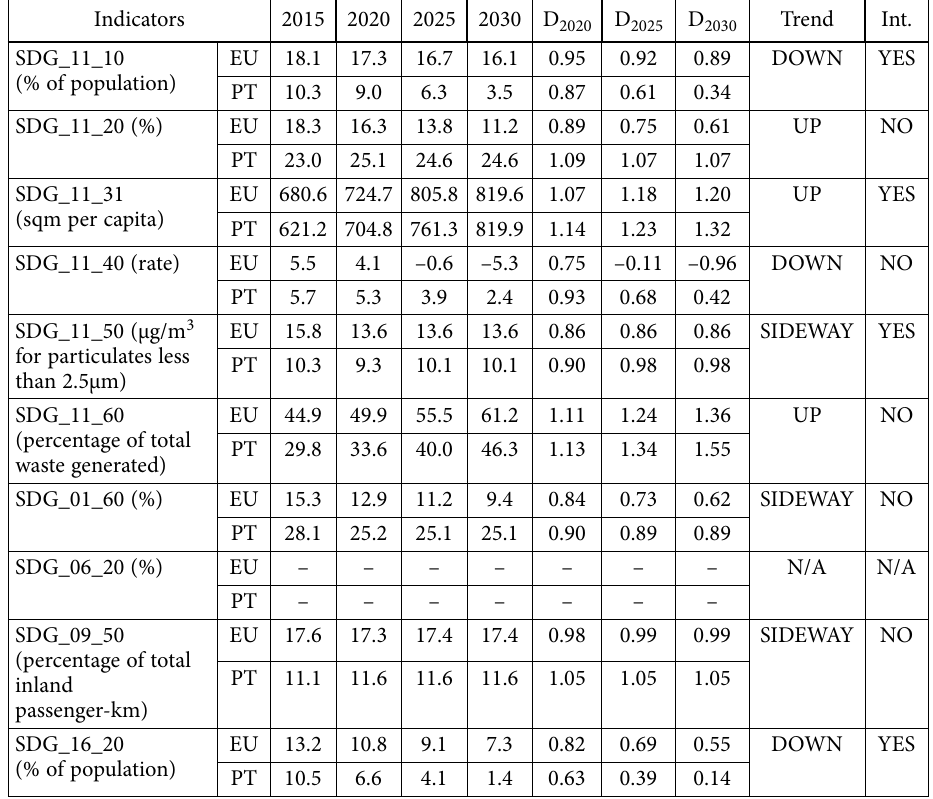
Table 12. SDG 11 – Sustainable cities and communities Indicators 2015 2020 2025 2030 D 2020 D 2025 D 2030 Trend